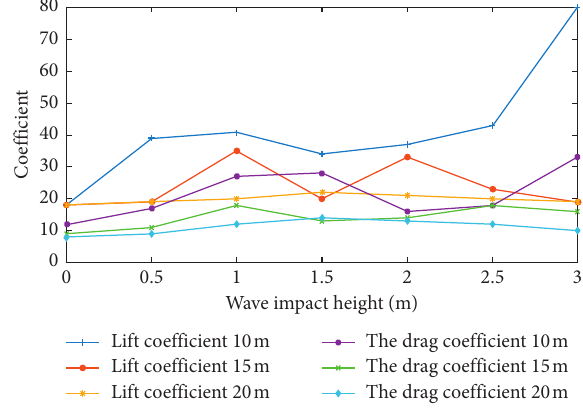
Figure 6: 100 lifting coefficient and drag coefficient in different water